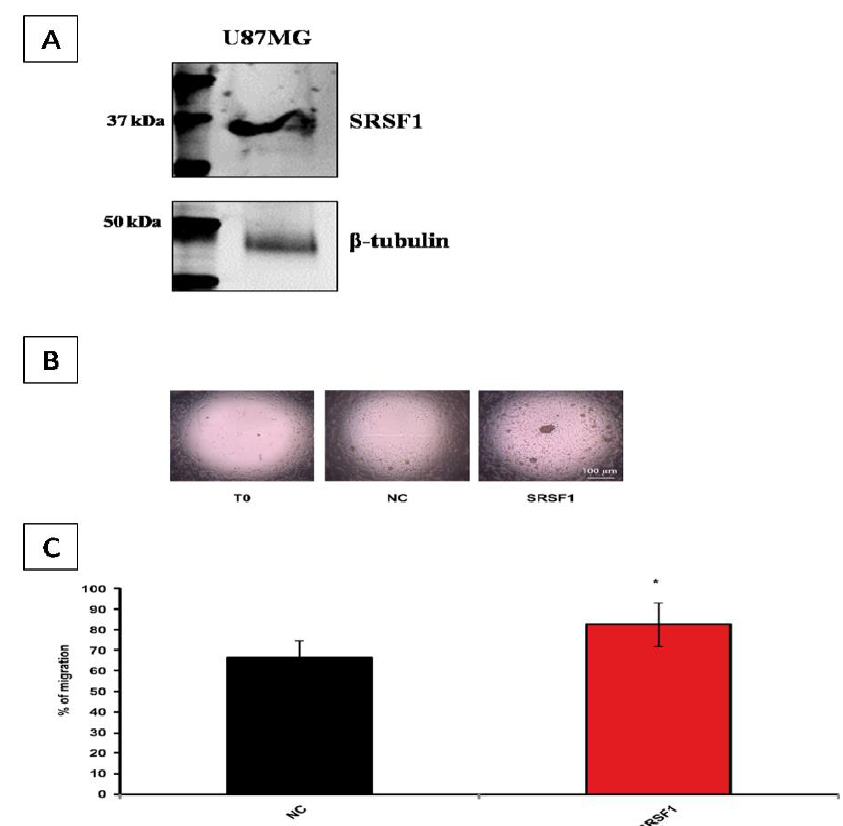
Figure 7. ( A ) Representative immunoblot of SRSF1protein on U87MG cells. β -tubulin was used as the loading control. ( B ) U87MG overexpressing SRSF1 migrated more than controls. Representative micrographs of migration of U87MG at T0 and at T24, in different experimental conditions: cells transfected with either empty pcDNA3 vector (NC) or SRSF1 expression vector. ( C ) Bar graph showing the mean ± standard deviation of the percentage (%) of NC or SRSF1-transfected U87MG cell migration. The percentage of cell migration has been calculated as previously reported [27]. * p -value < 0.05 ( n = 6, Student’s t -test vs. control).